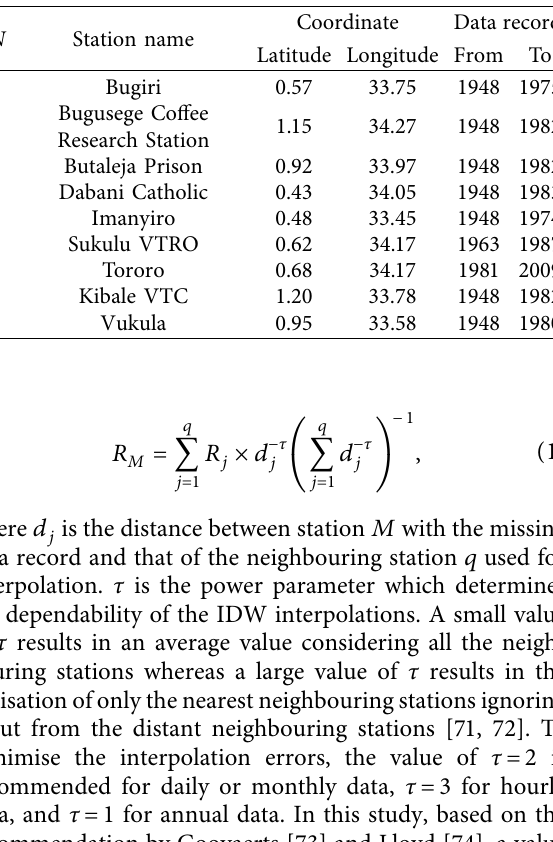
Table 1: Selected rainfall stations, their coordinates, and the data record